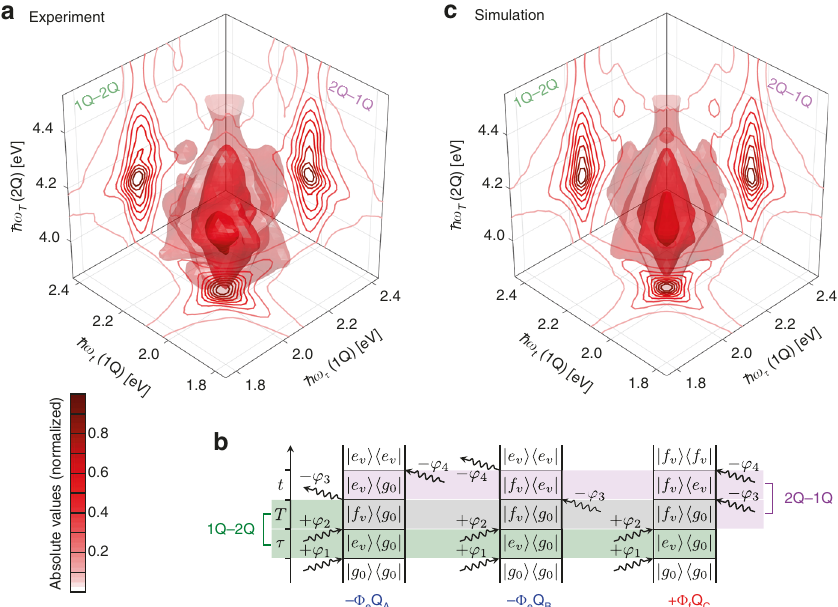
Fig. 4 Fourth-order three-dimensional 1Q – 2Q-1Q spectrum of TIPS – TAP 2 − in THF. a Experimental and c simulated 3D spectra, both shown in absolute values. Isosurfaces are drawn at 11, 25, and 60% of the maximal signal. Contour lines of the 2D projections are drawn at linearly spaced levels of each normalized projection. b Double-sided Feynman diagrams that correspond to the 1Q – 2Q – 1Q process, highlighting the coherence density matrix elements that are relevant for 1Q – 2Q and 2Q – 1Q 2D spectra in green and pink, respectively. Each pathway is labeled according to its sign, where Φ denotes the pathway-speci fi c fl uorescence quantum yield that is dependent on the fi nally prepared population state (marked by the